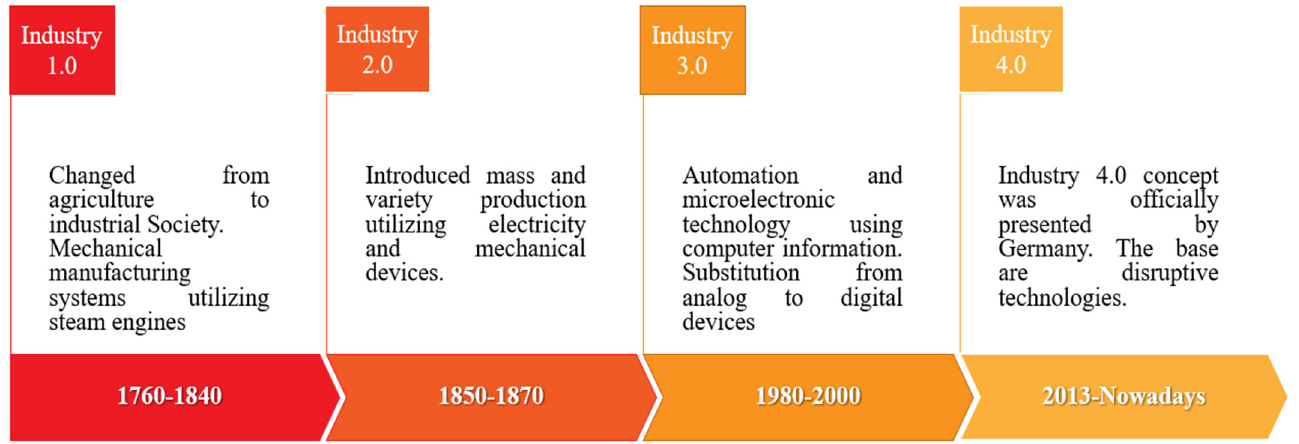
Figure 1. The Evolution from Industry 1.0 to 4.0. Source: Adapted from [2,3].